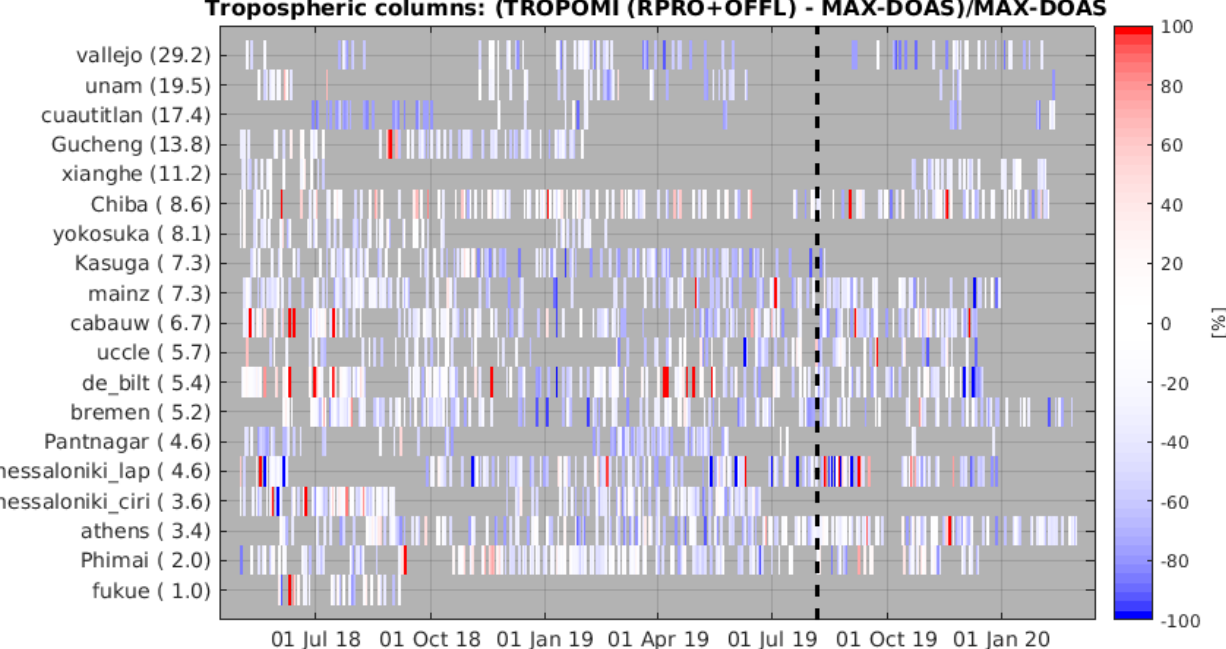
Figure 9. Percent relative difference between the S5P TROPOMI and MAX-DOAS NO 2 tropospheric column data as a function of time. Stations are ordered by median NO 2 tropospheric column (lowest median value at the bottom). The dashed vertical line on 6 August 2019 represents the reduction in S5P ground pixel size from 7 . 0 × 3 . 5 to 5 . 5 × 3 . 5km 2